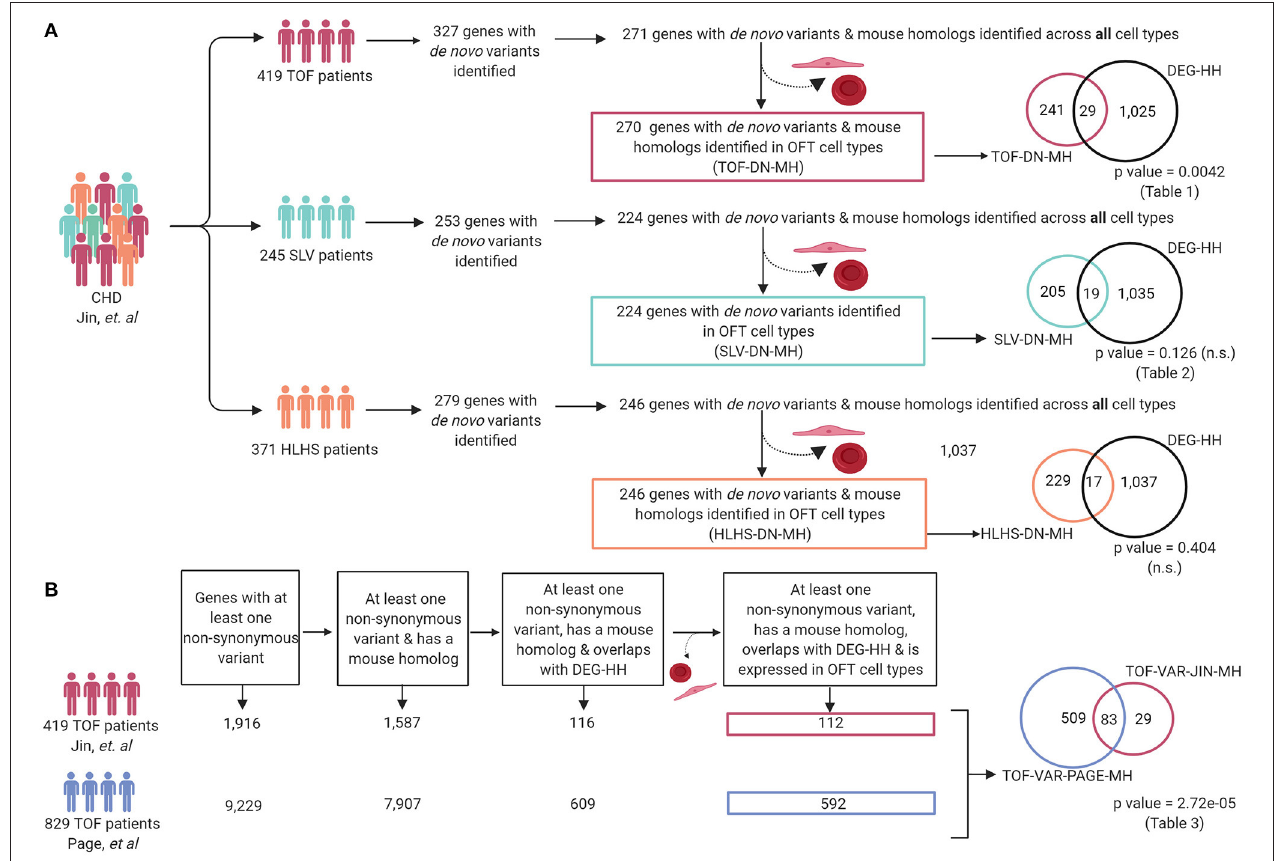
FIGURE 5 | Differentially expressed genes in Notch1 + / − ; Nos3 − / − compound mutants are enriched within reported genetic variants from TOF but not SLV and HLHS patients. (A) Patients with a primary TOF and SLV diagnosis and their associated de novo variant information were extracted from Jin et al. and compiled for analysis (TOF-DN-MH and SLV-DN-MH, respectively). Overlapping of TOF-DN-MH and SLV-DN-MH with DEG-HH demonstrated a significant enrichment of genes between TOF-DN-MH and DEG-HH but not SLV-DN-MH ( p -value = 0.0042 and p -value = 0.126, respectively). Overlapping of the HLHS-DN-MH cohort with DEG-HH failed